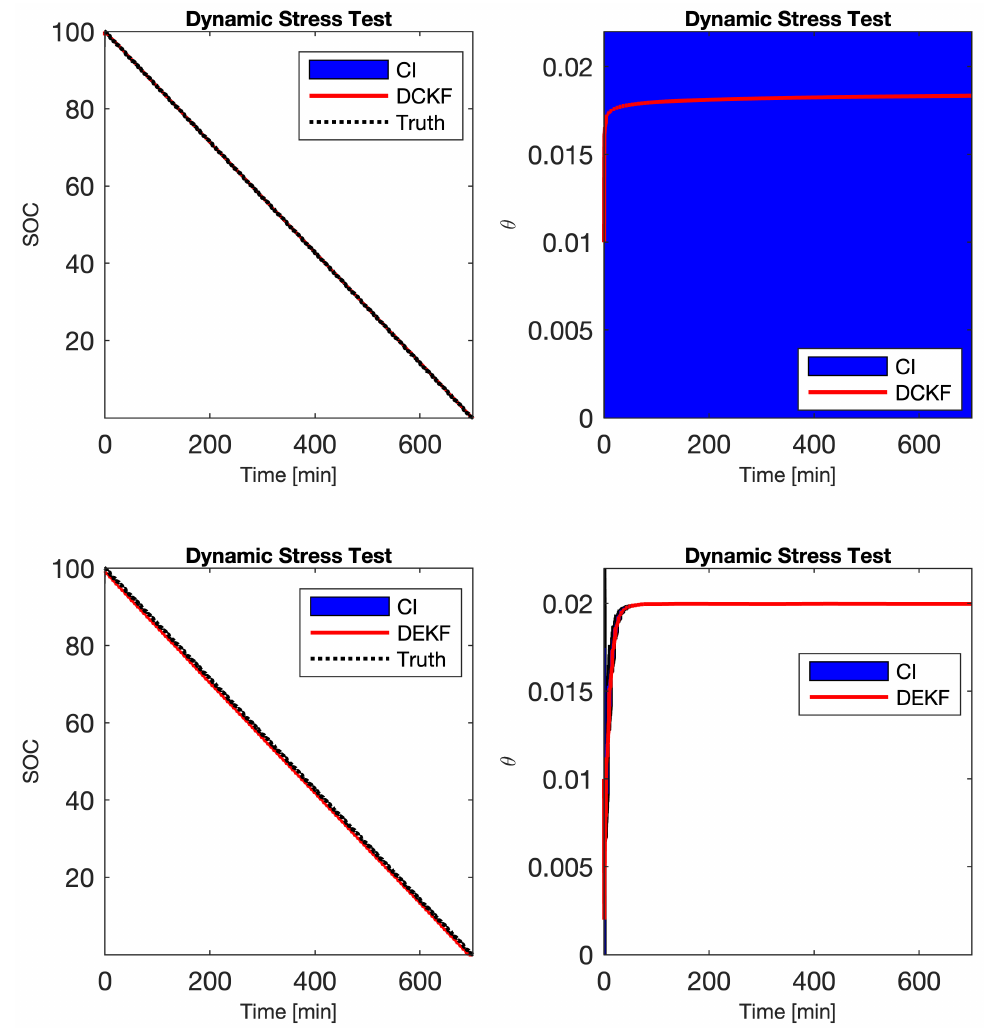
Figure 7. DST test confidence intervals for the DCKF in SOC estimation ( top left ) and internal resis- tance estimation ( top right ) as well as confidence intervals the DEKF in SOC estimation ( bottom left ) and internal resistance estimation ( bottom right